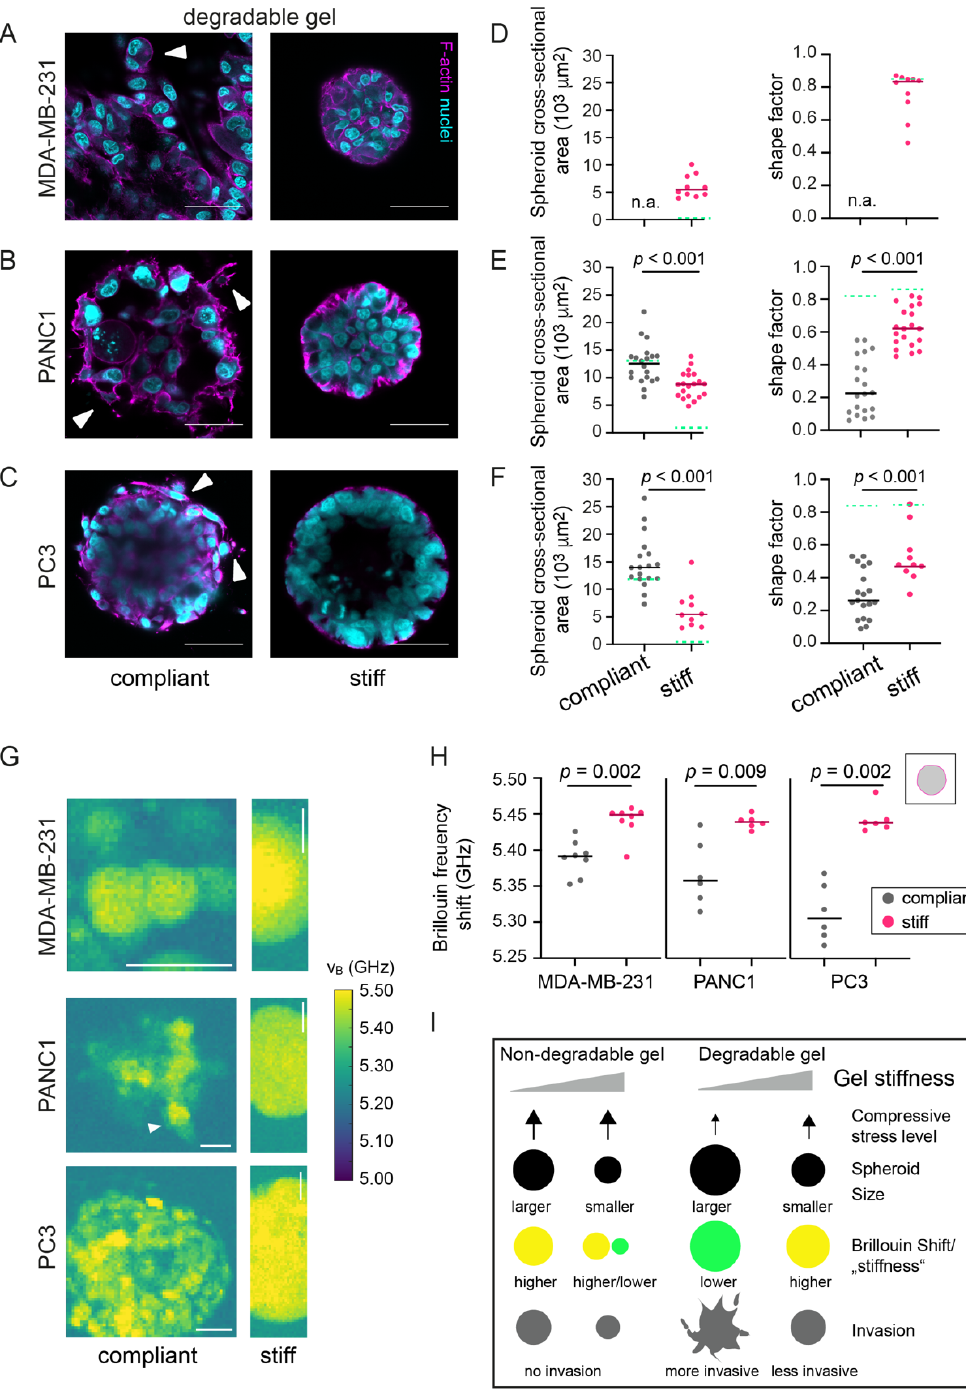
Figure 6. Invasive cancer cell lines (MDA-MB-231, PANC1 and PC3) show lower Brillouin frequency shift and invade into compliant degradable hydrogels. ( A – C ) Representative confocal microscopy images of MDA-MB-231 ( A ), PANC1 ( B ) and PC3 ( C ) spheroids grown in a compliant and stiff degradable gel. Scale bars correspond to 50 µ m. ( D – F ): Scatter plots showing cross-sectional area and number density of cells per unit area of respective spheroids in compliant and stiff degradable gels. n = 20 spheroids each. Solid lines indicate medians. Dotted green lines indicate medians of respective spheroids in non-degradable gels. ( G ) Representative Brillouin maps of MDA-MB-231, PANC1 and PC3 spheroids formed in a compliant and stiff degradable gel. Scale bars correspond to 25 µ m. ( H ) Scatter plots showing Brillouin frequency shifts for respective cell types. Lines indicate medians. n = 6–8 spheroids each. A Mann–Whitney test was done for statistical analysis. p -values are given. Spheroids analyzed after 14 days of culture. ( I ) Summary of results on compressive stress, spheroid growth, mechanics and invasion in dependence of matrix degradability and stiffness.